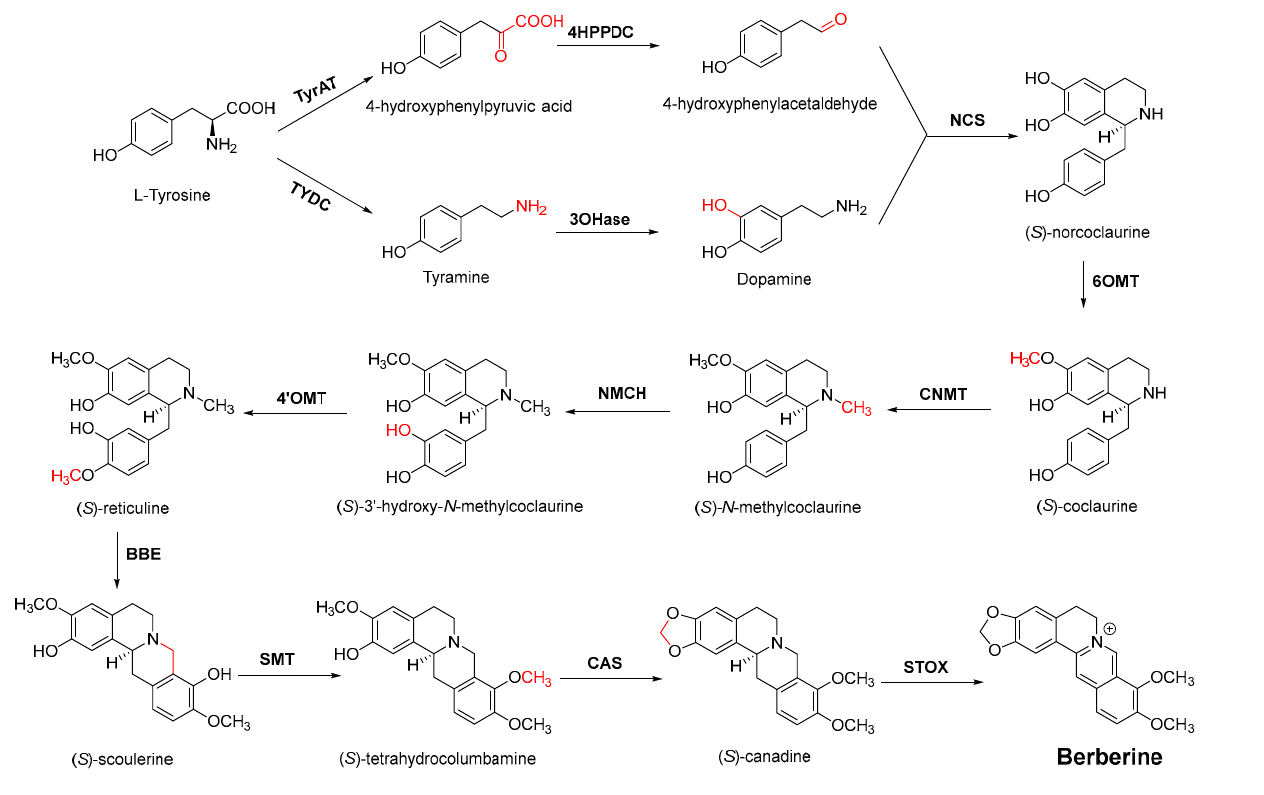
Figure 5. Biosynthesis pathway of the alkaloid antimicrobial agent berberine. TyrAT, L-tyrosine aminotransferase; 4HPPDC, 4-hydroxyphenylpuruvate decarboxylase; TYDC, tyrosine decarboxylase; 3OHase, tyrosine/tyramine 3-hydroxylase; NCS, ( S )-norcoclaurine synthase; 6OMT, SAM: norcoclaurine 6- O -methyltransferase; CNMT, ( S )-coclaurine N -methyltransferase; NMCH, N -methylcoclaurine 3 ′ -hydroxylase; 4 ′ OMT, SAM: 3 ′ -hydroxy- N -methylcoclaurine 4 ′ - O -methyltransferase; BBE, berberine bridge enzyme; SMT, SAM: scoulerine 9- O -methyltransferase; CAS, ( S )-canadine synthase; STOX, ( S )-tetrahydroprotoberberine oxidase.